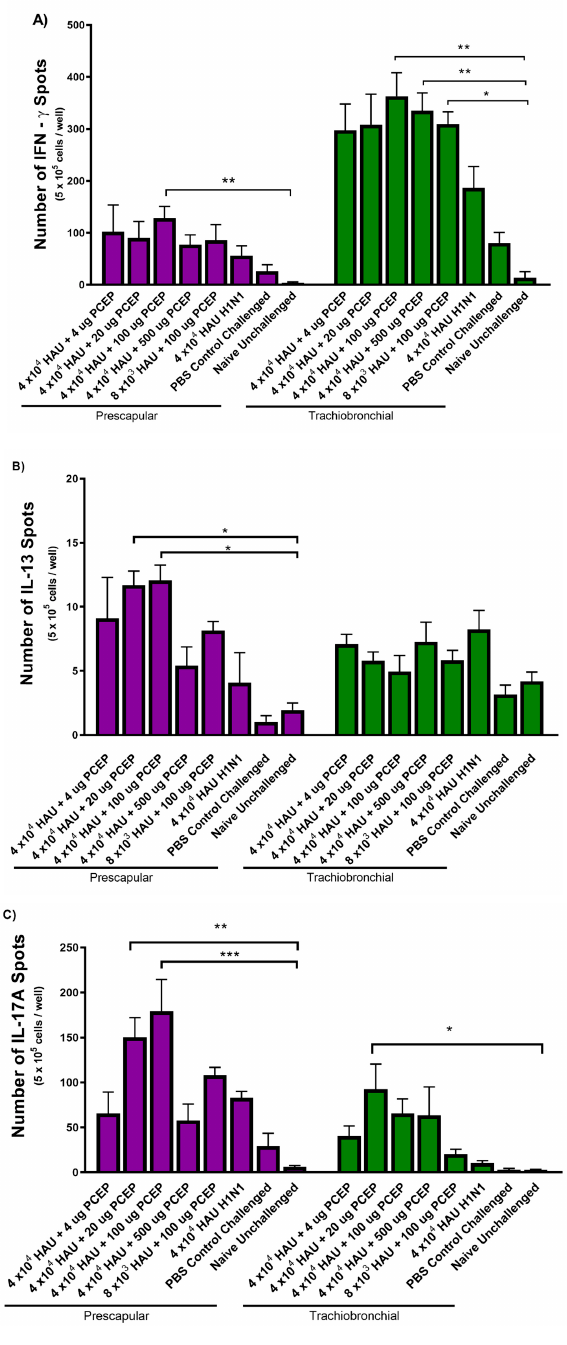
Figure 4. Adjuvant PCEP induces immune responses against inactivated swine influenza virus H1N1. Pigs ( n = 6) were immunized then boosted at day 21 via intradermal routes with 4 × 10 4 or 8 × 10 3 HAU H1N1 plus 0–500 μ g PCEP adjuvant as indicated. They were challenged with 8 × 10 5 PFU virulent H3N2 SIV via the intratracheal route on day 35 and killed 6-days after challenge. Tracheobronchial and prescapular lymph nodes were collected and cells were harvested at 41 days post immunization. Individual single-cell suspensions of 5 × 10 5 lymph node cells were re-stimulated with killed SIV H1N1 for 16 h for IFN- γ ( A ), and 48 h for IL-13 ( B ) and IL-17A ( C ) and measured by ELISPOT analysis. Data for animal groups are presented as a bar graph with the mean and standard error of the mean presented. p < 0.05 (*), p < 0.01 (**) and p < 0.001 (***). Previously, we showed that pigs immunized intradermally, with inactivated H1N1 swine influenza virus were protected against homologous challenge [13]. Here, animals were challenged with heterologous SIV H3N2 virus to determine whether the PCEP-adjuvanted H1N1 vaccine was cross-protective. All challenged animals had lung lesions (Figure 5) indicating that the vaccine did not protect against heterologous challenge.